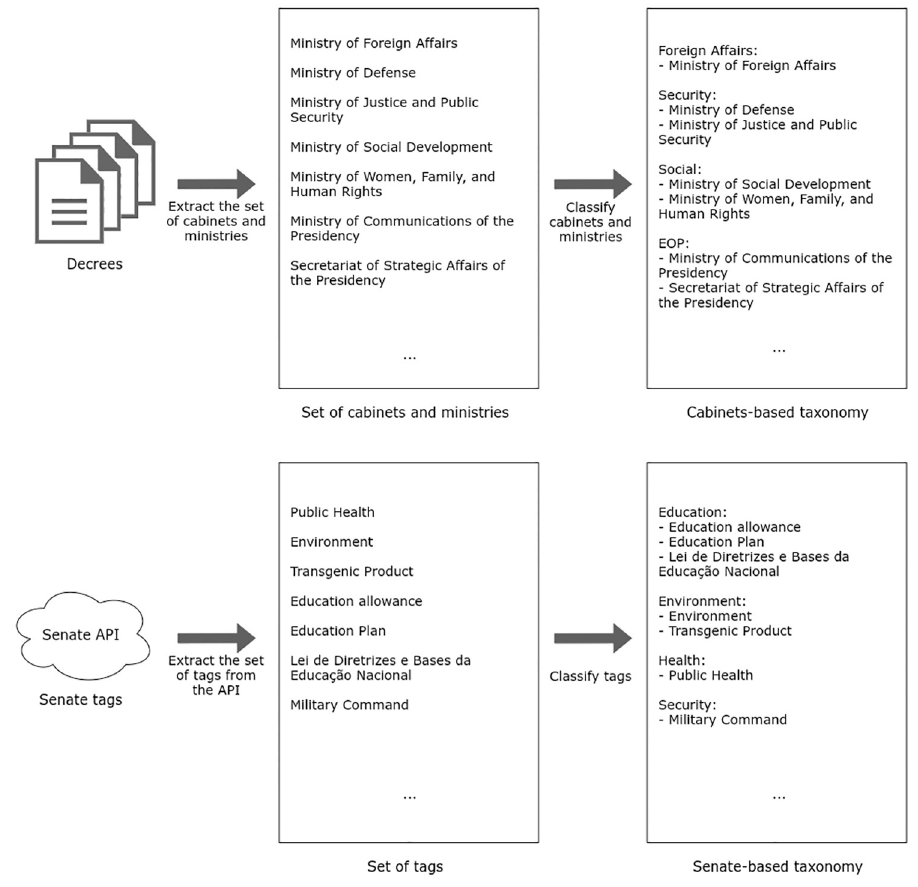
Fig 3. Process of creation of